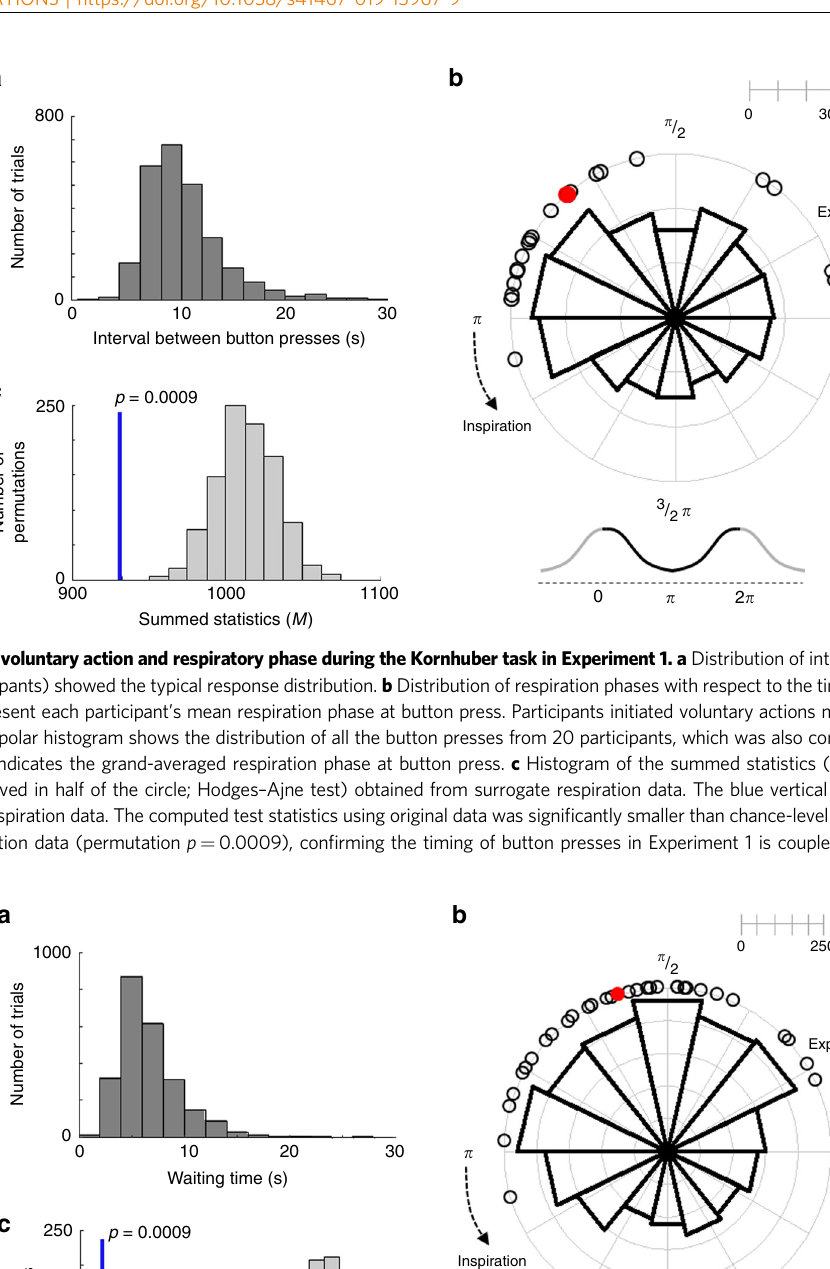
in an otherwise identical experimental setup.